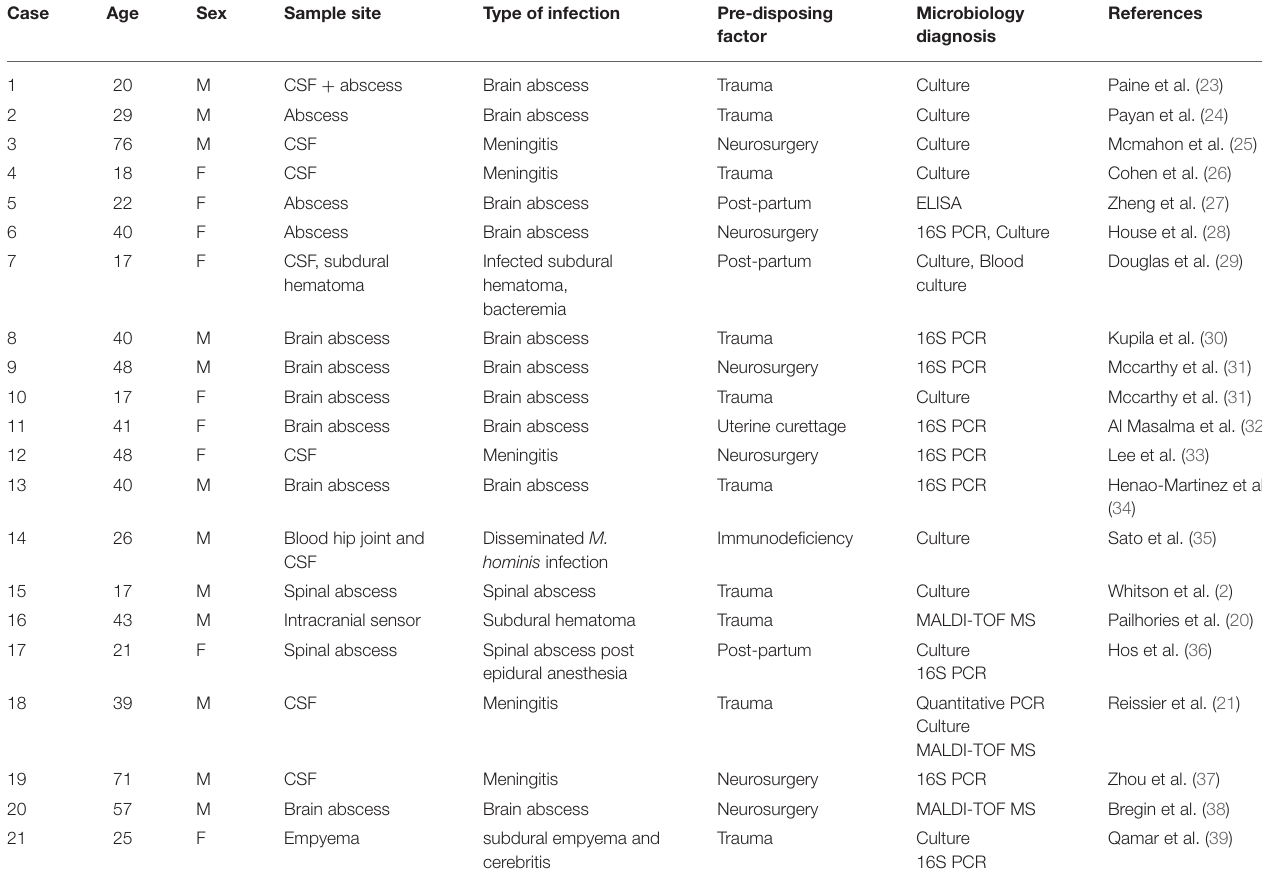
TABLE 1 | Adult cases of M. hominis CNS infection.